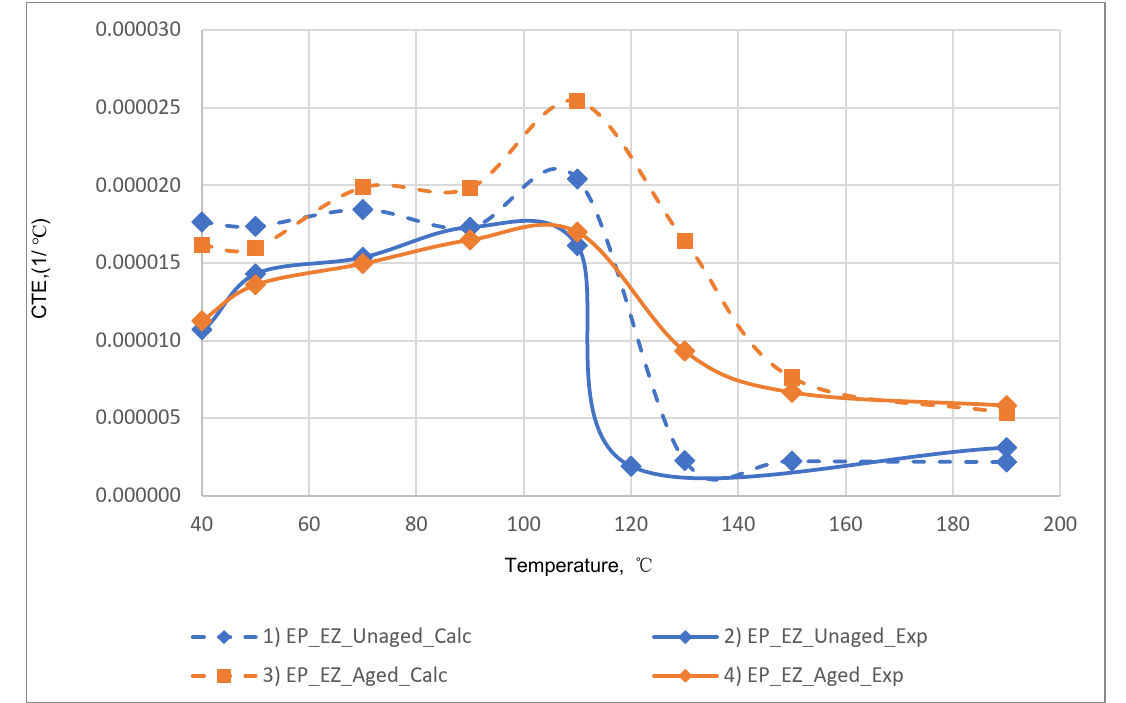
Figure 15. Dependence of CTE on temperature for epoxy fiberglass on glass fabric EZ-200: (1) calculated for EP-EZ200; (2) experimental for EP-EZ200; (3) calculated for EP-EZ200-TA; (4) experimental for EP-EZ200-TA.